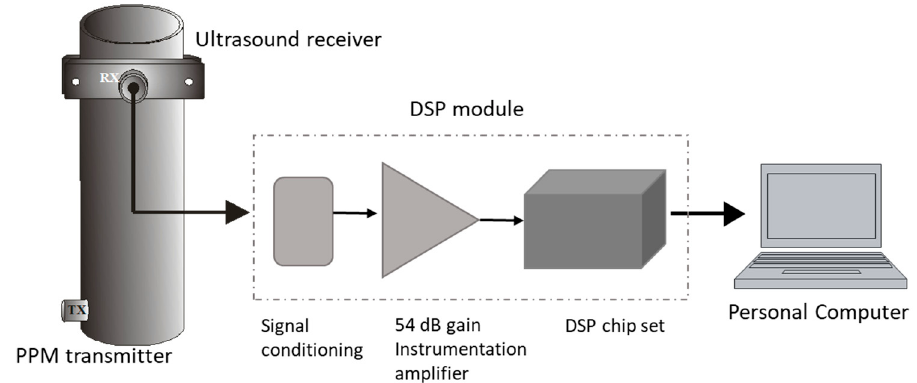
Figure 5. Receiver instrumentation’s main components.